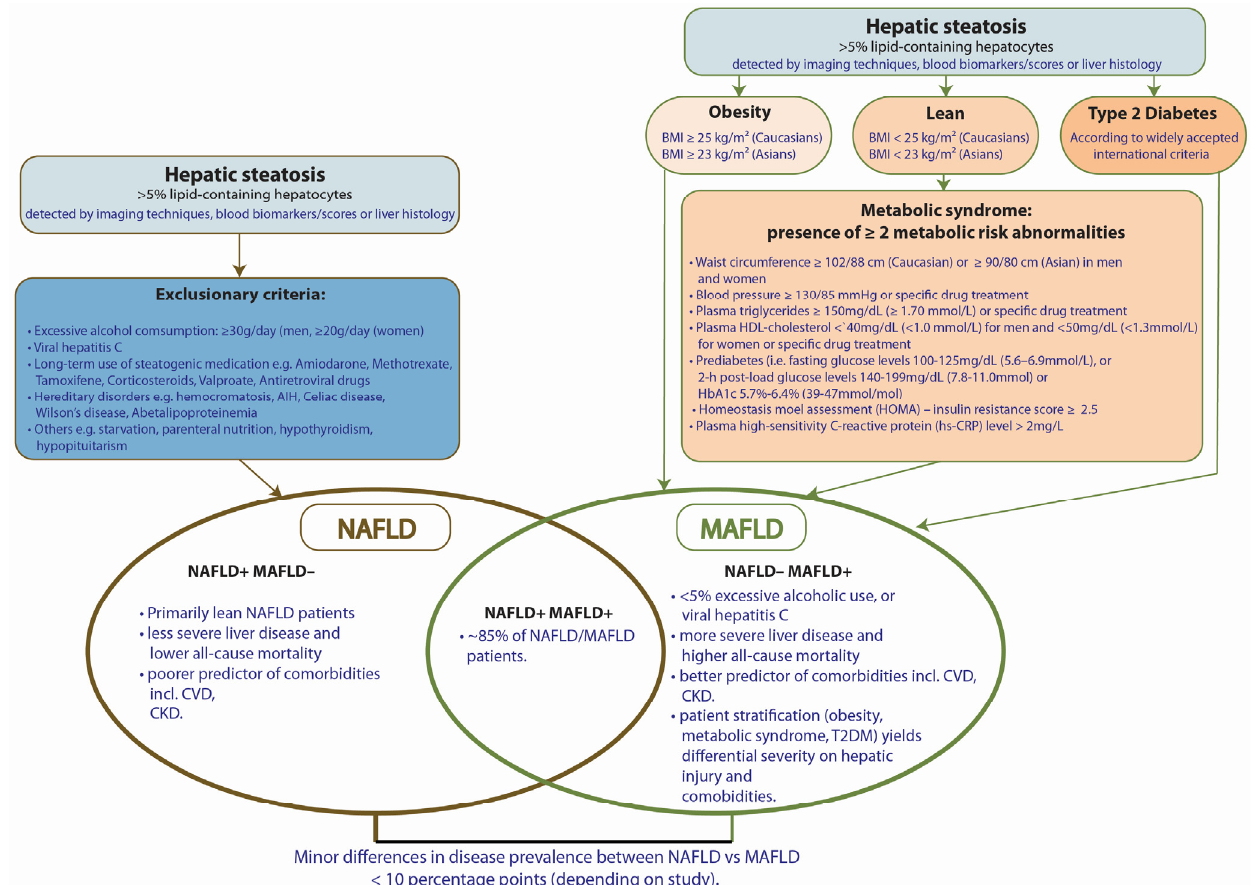
Figure 2. Definitions and clinical implications of the change in NAFLD nomenclature to MAFLD.